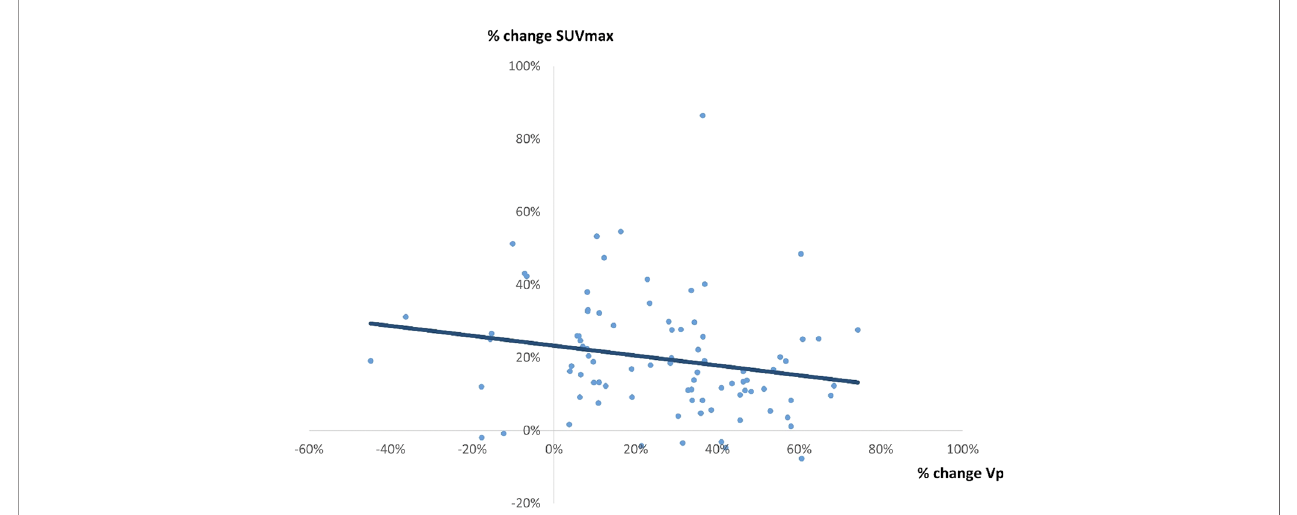
FIGURE 4 | A correlation between % change in SUV max and % change in Vp by 4D PET/CT scan. A weak correlation was observed (r = 0.2117, p = 0.0359, y = -0.1356x +